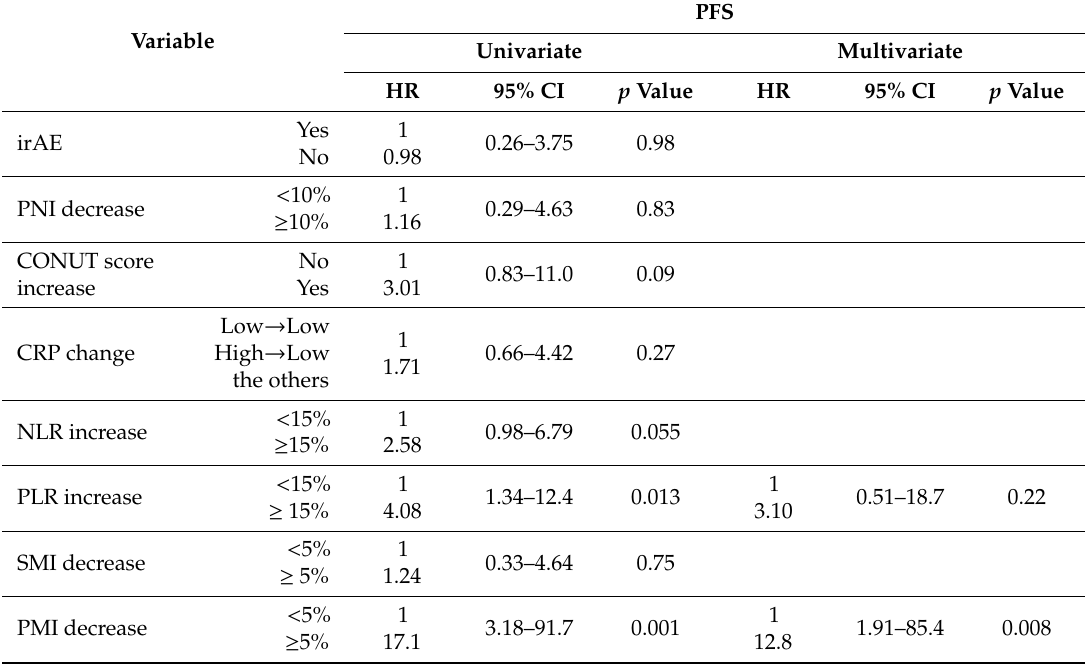
Table 4. Univariate and multivariate analysis for correlation between PFS and changes of various markers 1M after the first